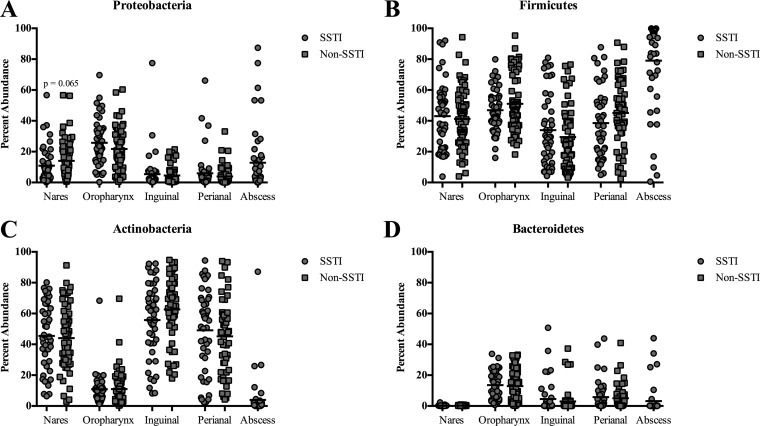
Percent abundance of the various bacteria phyla at the 4 body sites and abscesses. The data for each body site are broken into individuals who either had SSTI (circles) or did not have SSTI (non-SSTI) (squares). Each symbol corresponds to an individual sample. The black line represents the mean abundance. For Proteobacteria in the nares, the P value shown was generated using the Mann-Whitney statistical test.